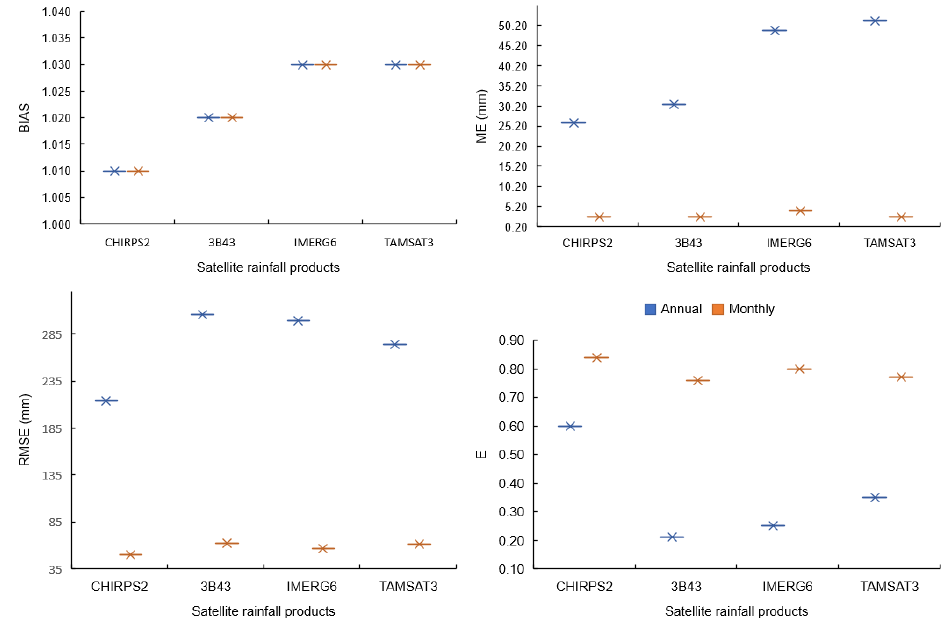
Figure 5. Statistical indices of the four SREs for the DRB at annual and monthly